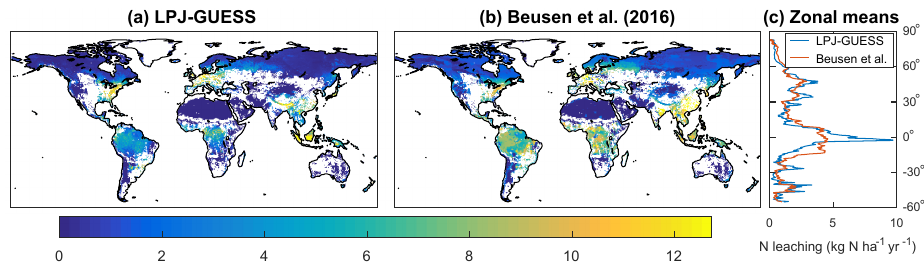
Figure 9. Mean mineral N leaching rate for 1999–2000 compared to estimates of Beusen et al. (2016). (a) Prediction by LPJ-GUESS for the true historical simulation ( + Ndep + clim + CO 2 ). (b) Estimate of Beusen et al. for natural ecosystems only. (c) Latitudinal averages. The many missing values in the maps are caused by mask for natural land cover of Beusen et al. (2016) which was applied to both data sets (see Sect.